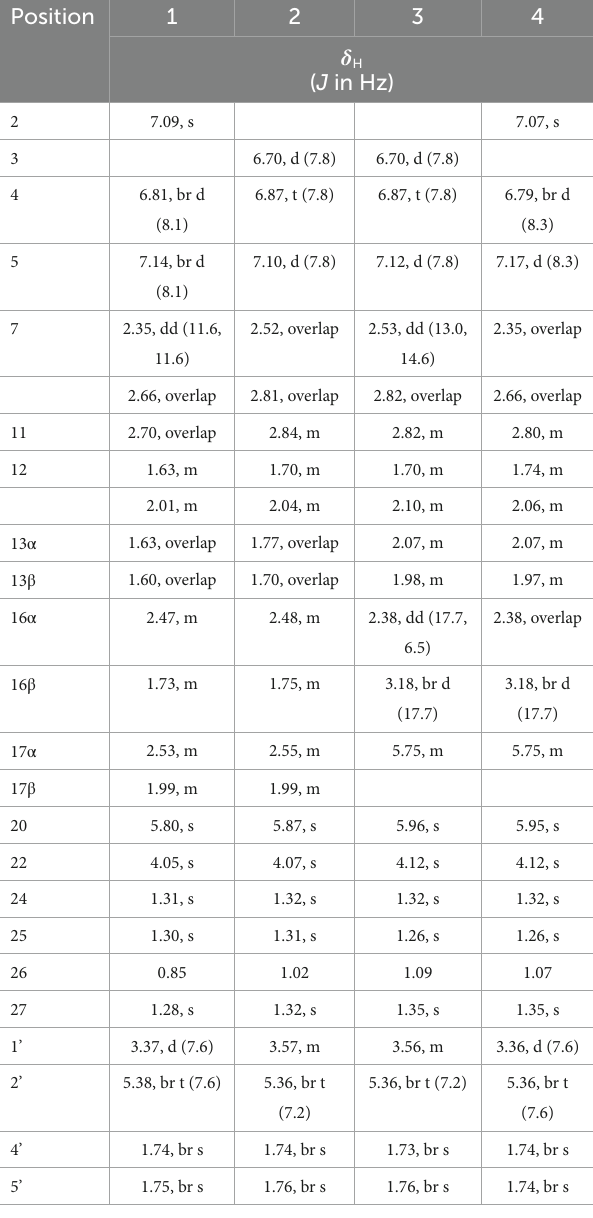
TABLE 2 The 1 H NMR (400 MHz) data of compounds, 1-4 in CD 3 OD.